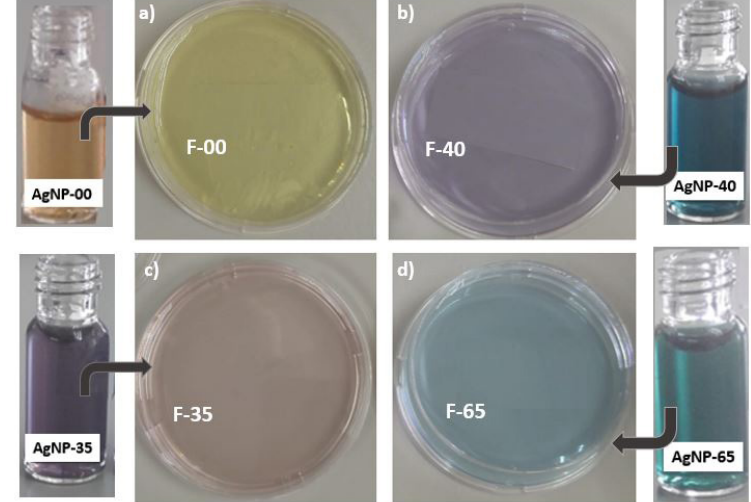
Figure 4. Different AgNPs loaded PVA films prepared from precursor AgNPs dispersions indicated next to each